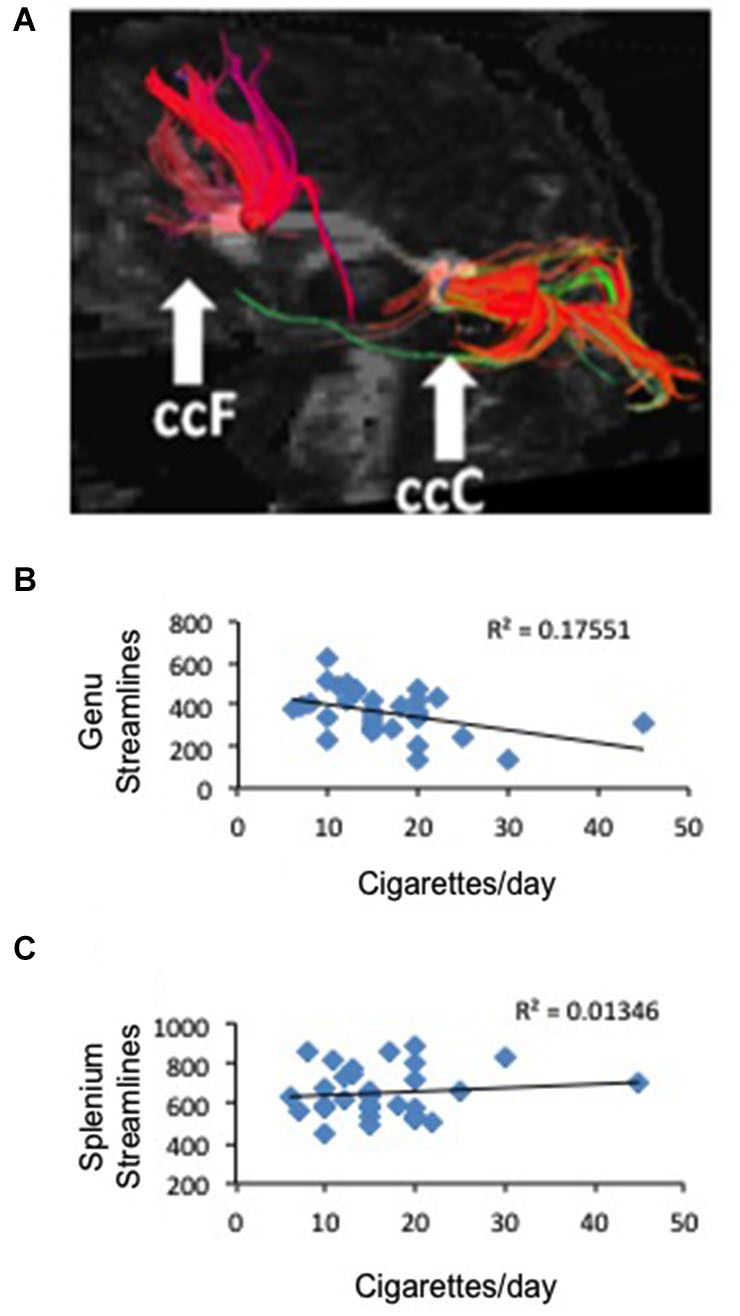
Correlation between frontal anatomical connectivity as measured with DTI and average number of cigarettes smoked per day. (A) Two callosal ROIs (genu and splenium) and streamlines that pass through each ROI (one representative subject is shown) (B) Significant negative correlation between number of streamlines in the genual ROI and average number of cigarettes per day p < 0.02. (C) No correlation between number of streamlines in the splenium ROI and average number of cigarettes per day.